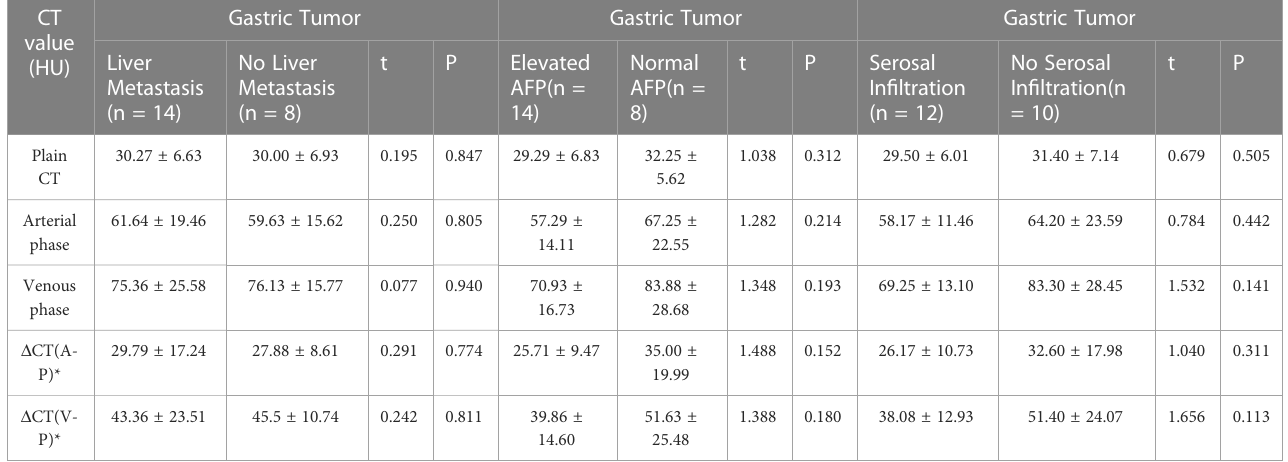
TABLE 2 CT values of a gastric